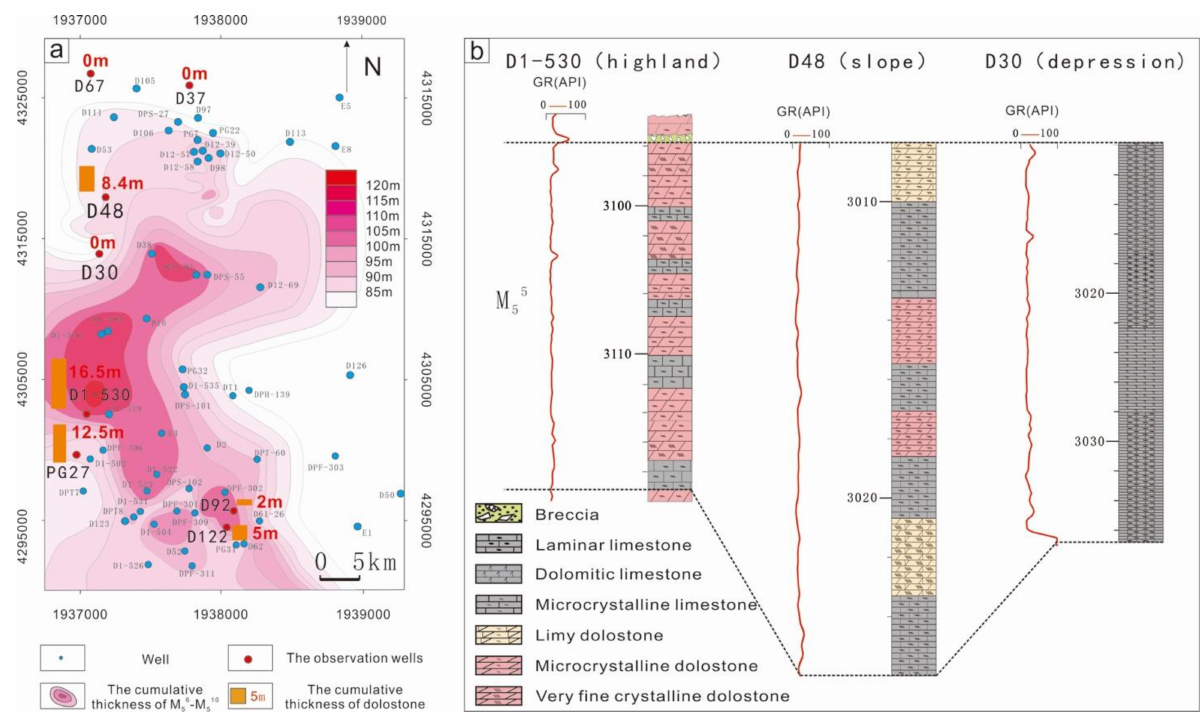
Figure 8. The relationship between the thickness of dolostone and paleogeomorphology in M 5 5 in Daniudi Gas Field, Ordos Basin: ( a ) dolostone thickness distribution and paleogeomorphology characteristics; ( b ) dolomite thickness and lithological cycles characteristics under different paleogeomorphology in the M 55